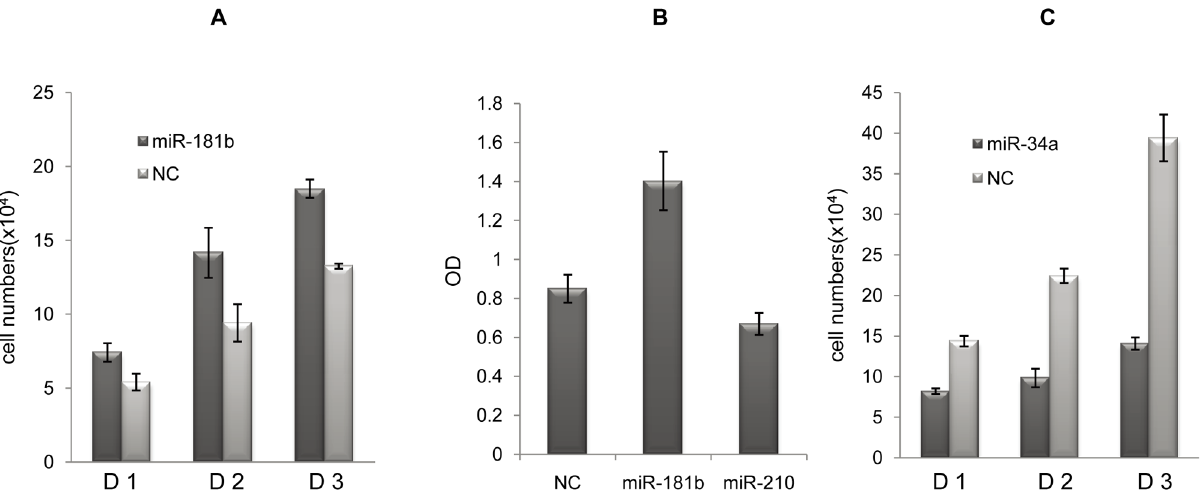
Figure 1. Cell growth assay of miR-181b- and miR-34a-transfected tumor cells. Hela cells (A), CNE cells (B) and HCT 116 cells (C) were transfected with the mimics of miR-181b, miR-34a and miR-210. Small RNA with random sequence (NC) was used as a control. Cells were cultured for three days and cell numbers were counted every day (A and C) or SRB (sulforhodamin B) was used for cell growth assay (B).